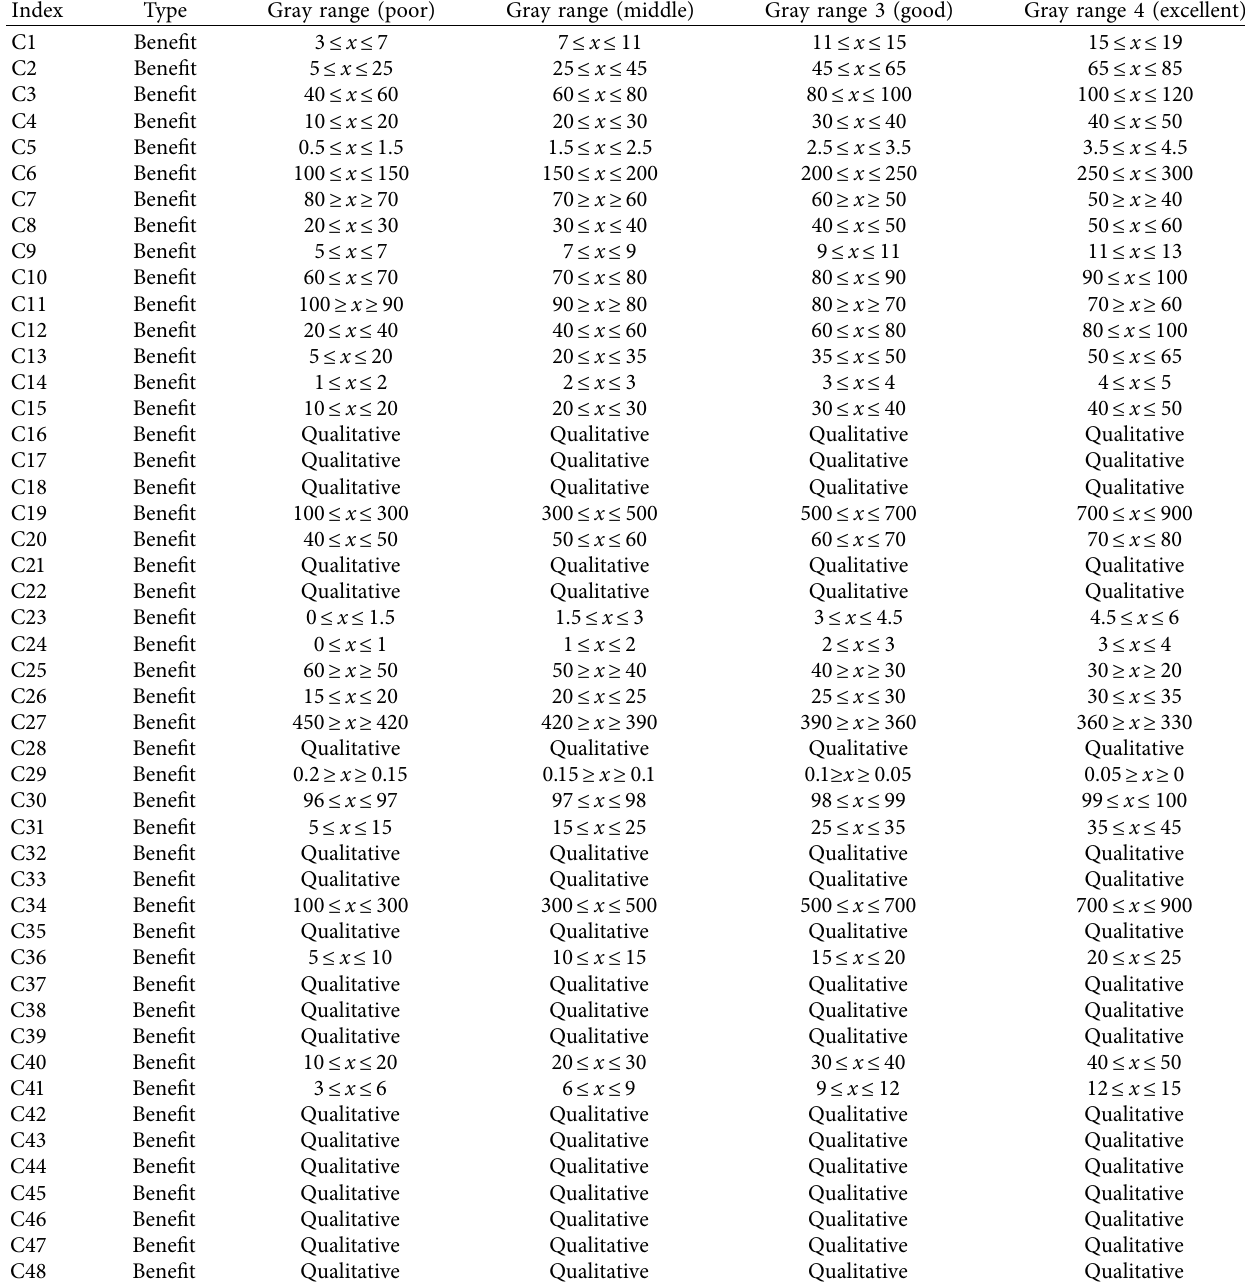
Table 3: Gray ranges for each